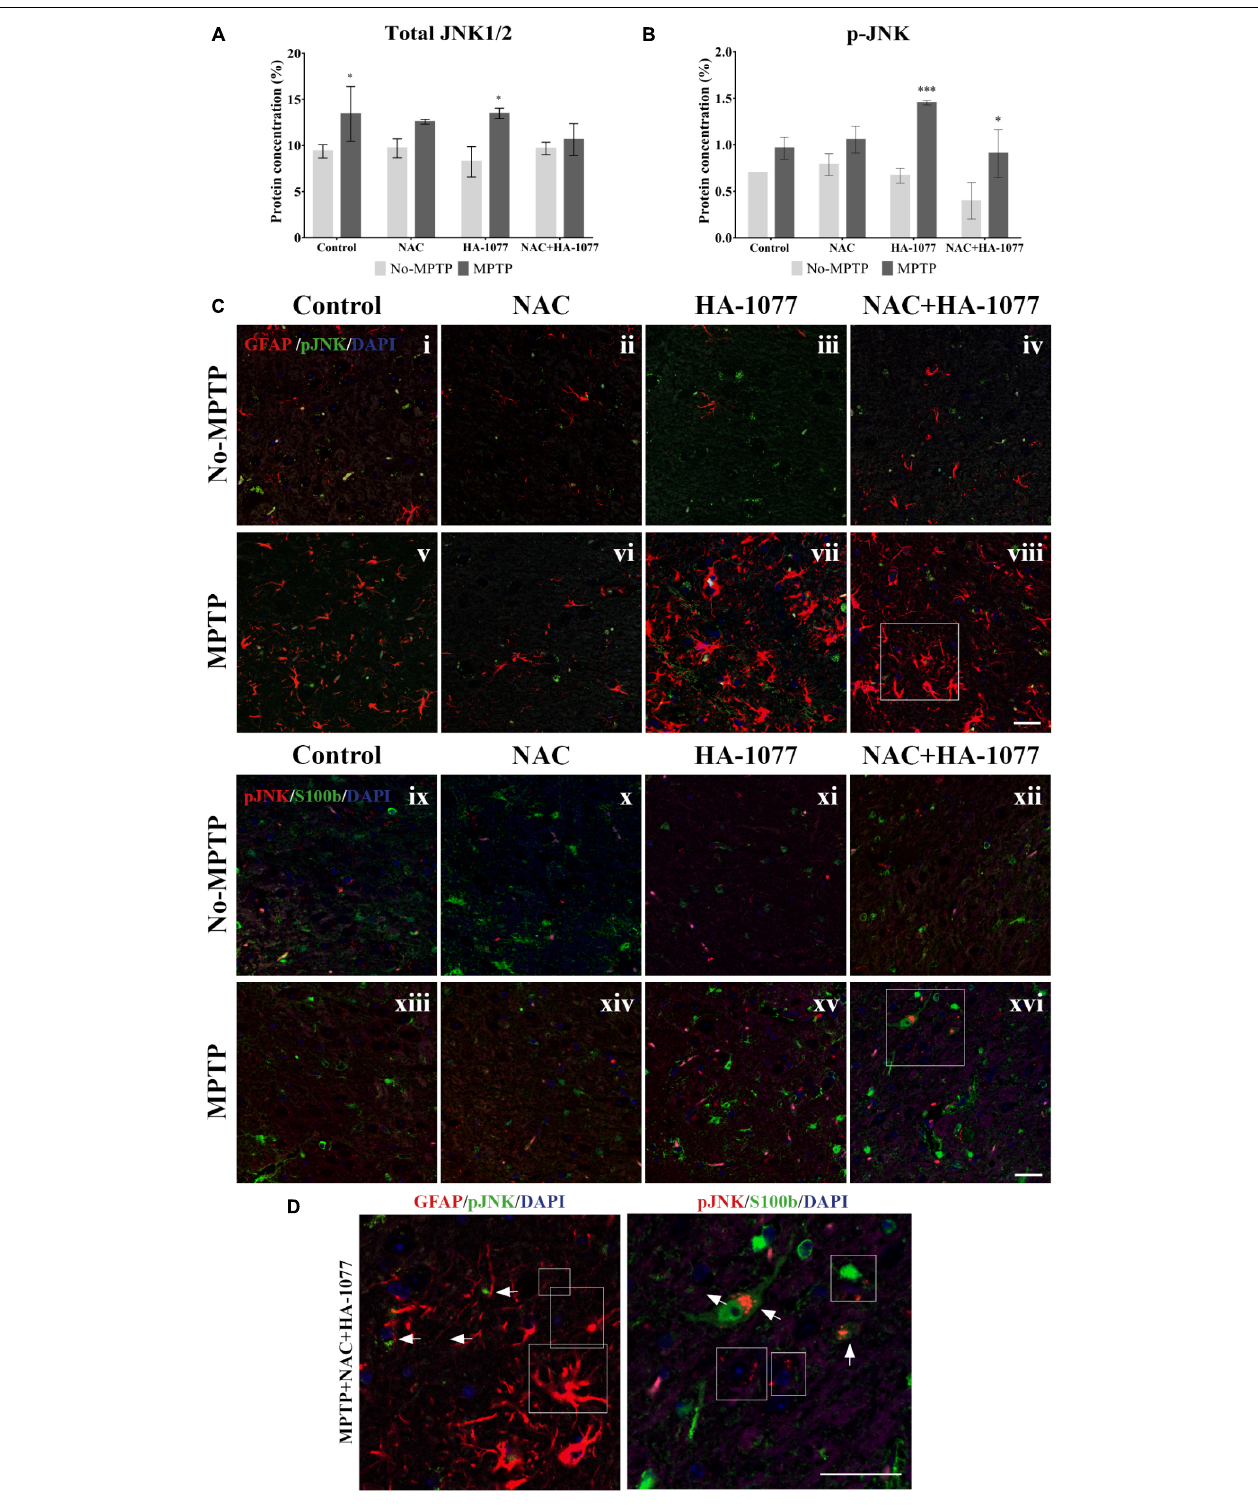
FIGURE 6 | Quantification of total and phospho-JNK1/2 expression by ELISA in midbrains of old-Parkinsonian mice. (A) There was a significant increase in protein concentration (%) of total JNK1/2 in MPTP ( ∗ p = 0.0321) and MPTP+HA-1077 ( ∗ p = 0.0129) groups compare with their controls. (B) Quantification of p-JNK concentration (%) by ELISA in midbrains of old-Parkinsonian mice. p-JNK expression was significantly increase in MPTP+HA-1077 ( ∗∗∗ p = 0.0007) and